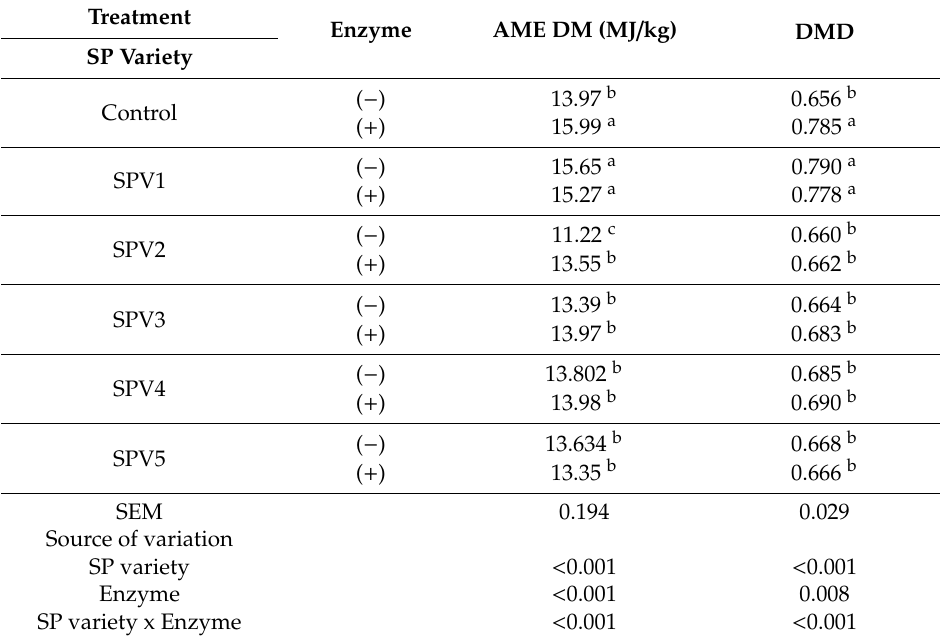
Table 6. AME values and dry matter digestibility of treatment